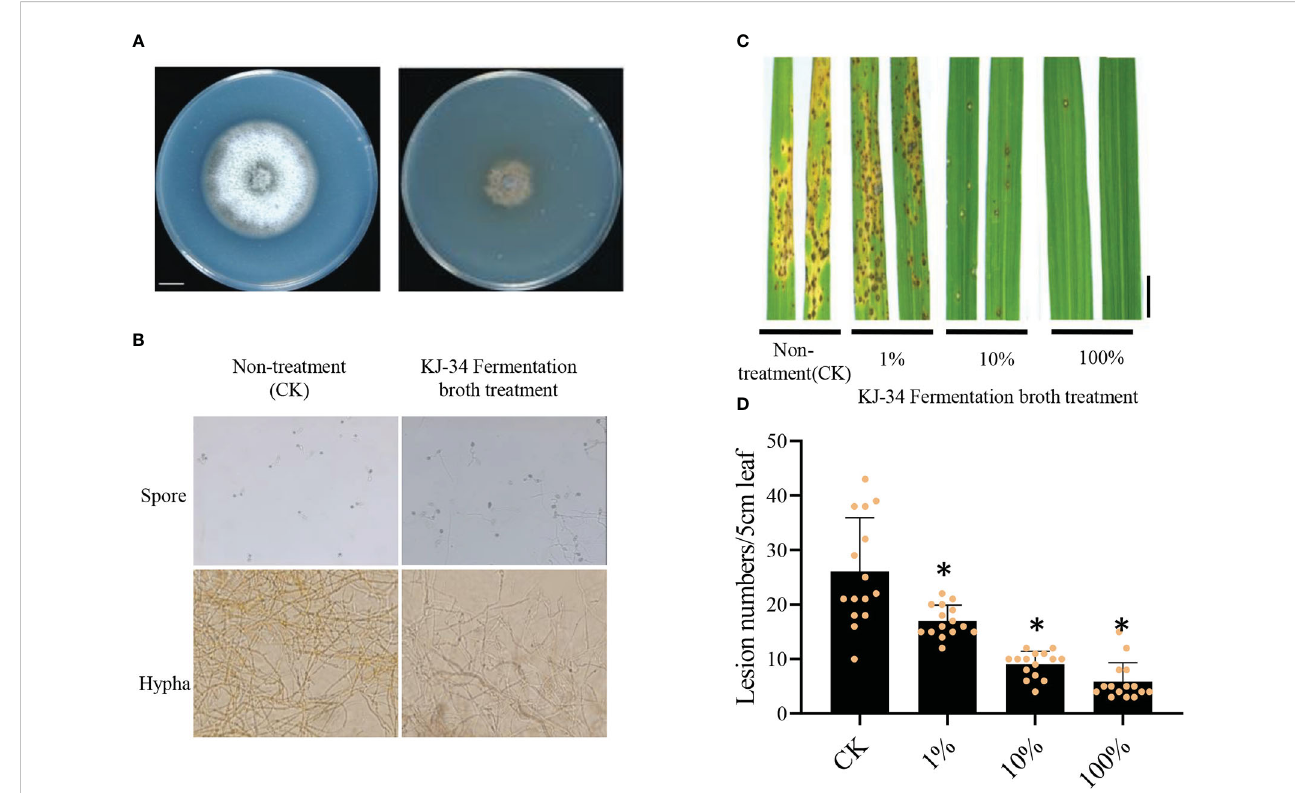
FIGURE 3 Biological control effect of the KJ-34 fermentation fi ltrate against rice blast. (A) Effects of the KJ-34 fermentation fi ltrate on the growth of (B) M. oryzae . M. oryzae was photographed after being inoculated for 6 days. (C) Rice leaves sprayed with the KJ-34 fermentation fi ltrate before inoculation with Guy11 spores. (D) Blast disease lesion density was quanti fi ed from infected leaf segments of 5cm in length at 5days post infection ( n =15 independent leaves; mean±SD, two-sided Student ’ s t -test). * p < 0.05 (two-sided